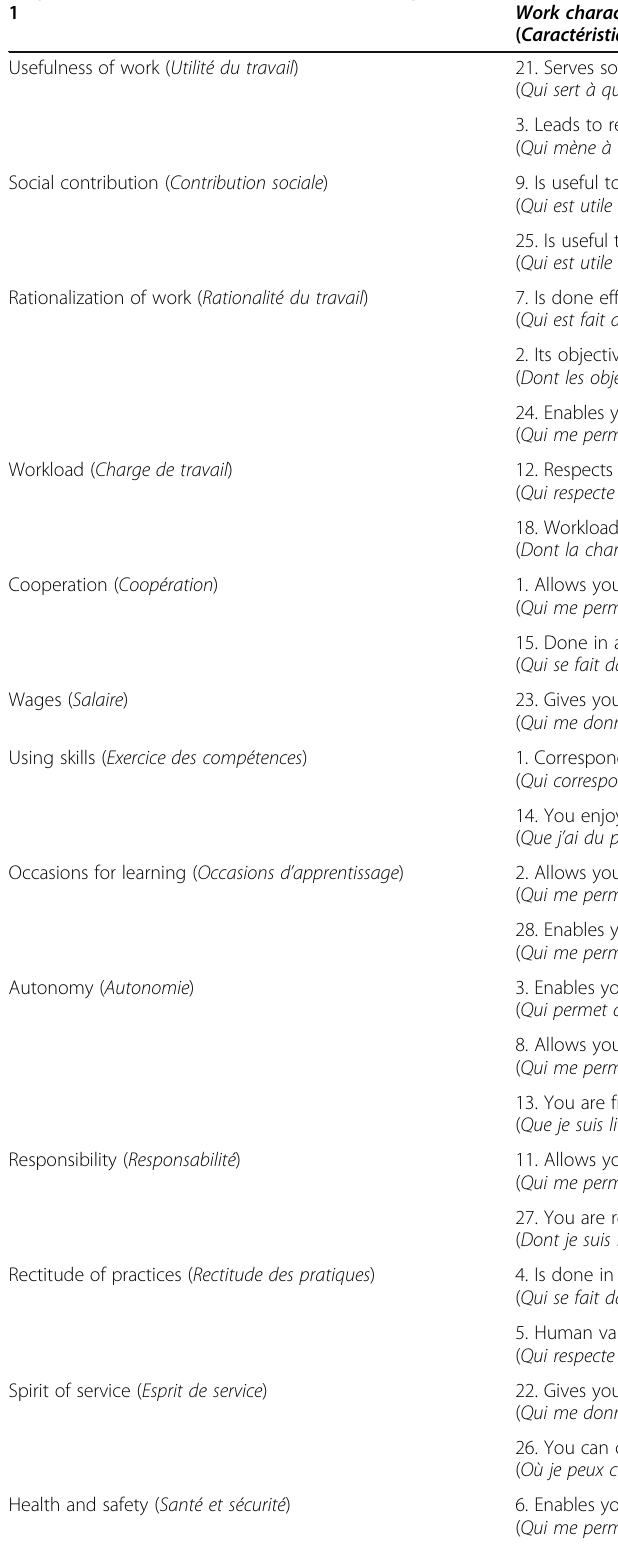
Items from the questionnaire with the original item numbers Work characteristics that have meaning : ( Caractéristiques du travail qui a du sens )*: